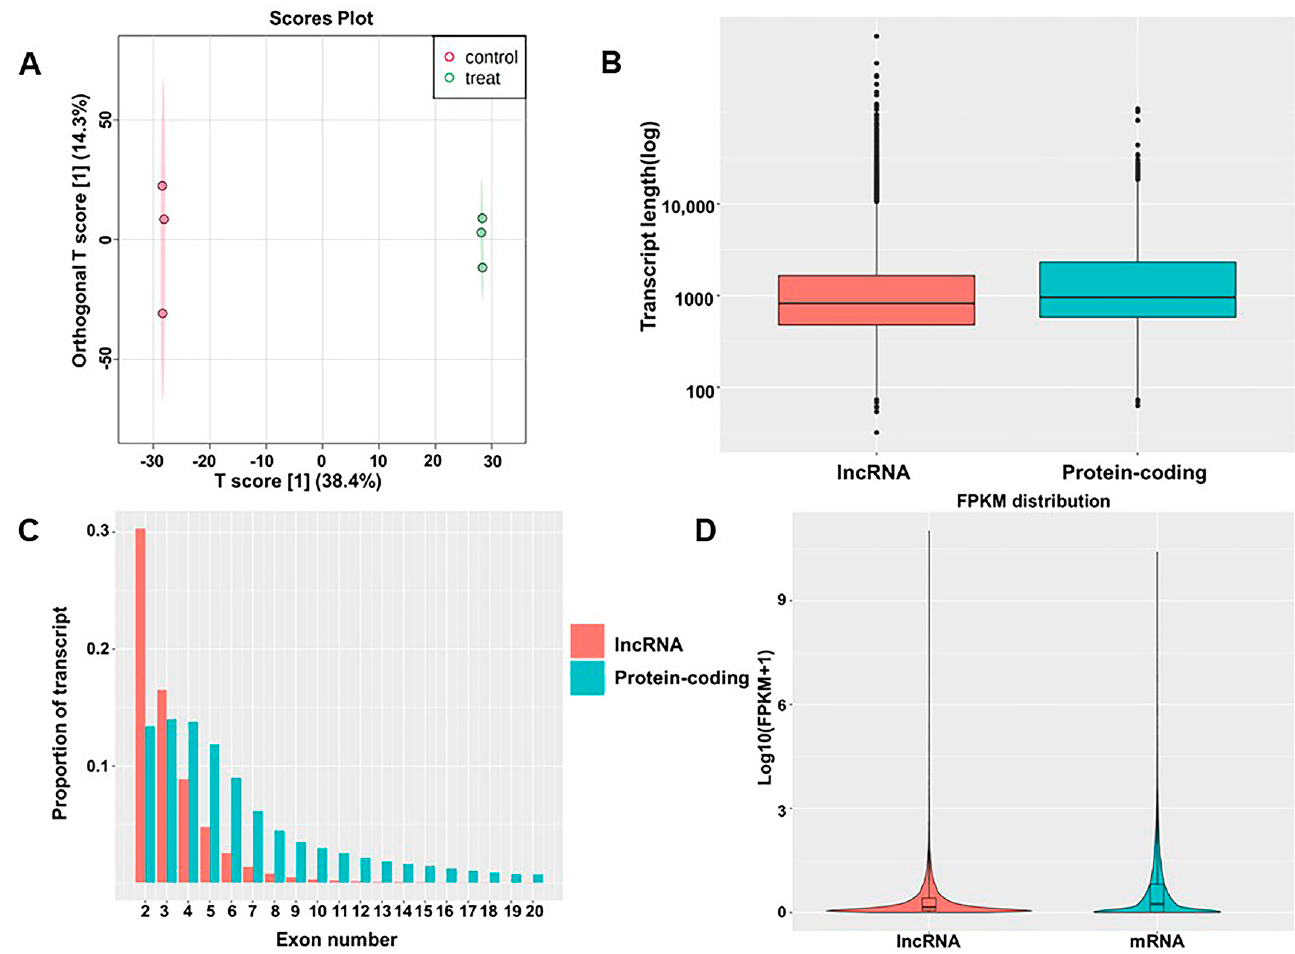
Figure 1. Identification of lncRNAs and comparison with mRNAs. ( A ) OPLS − DA of lncRNAs; ( B ) lengths of lncRNAs and mRNAs; ( C ) exon numbers of lncRNAs and mRNAs; ( D ) expression levels of mRNAs and lncRNAs.